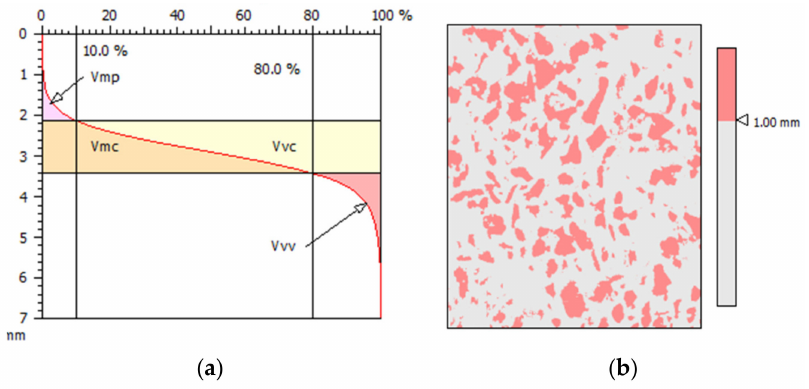
Figure 11. ( a ) Abbott curve and the volume parameters; ( b ) projected area (data from